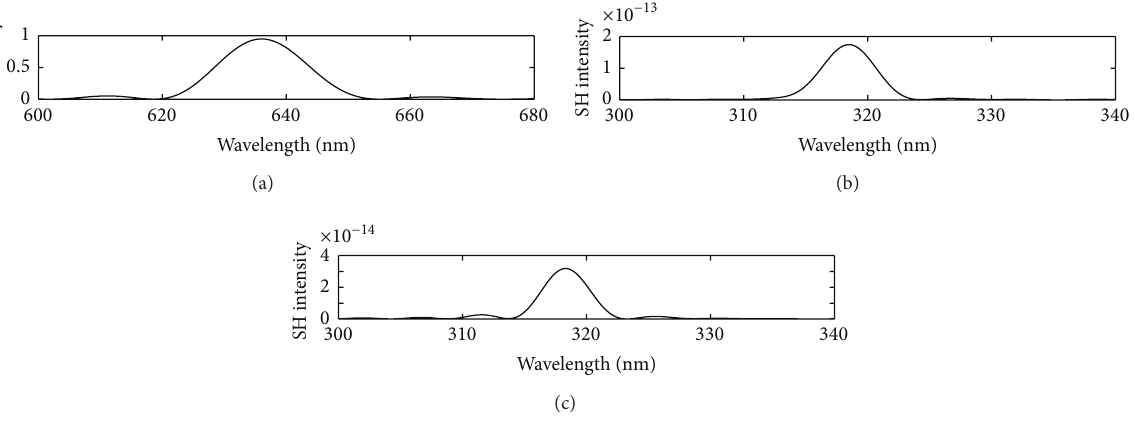
Figure 3: (a) The FTS for 𝐸 (1) 𝑦 component of fundamental frequency field at the wavelength 636 nm. The FTS for (b) 𝐸 (2) 𝑥 and (c) 𝐸 (2) 𝑦 component of second-harmonic generation at the wavelength 318nm.